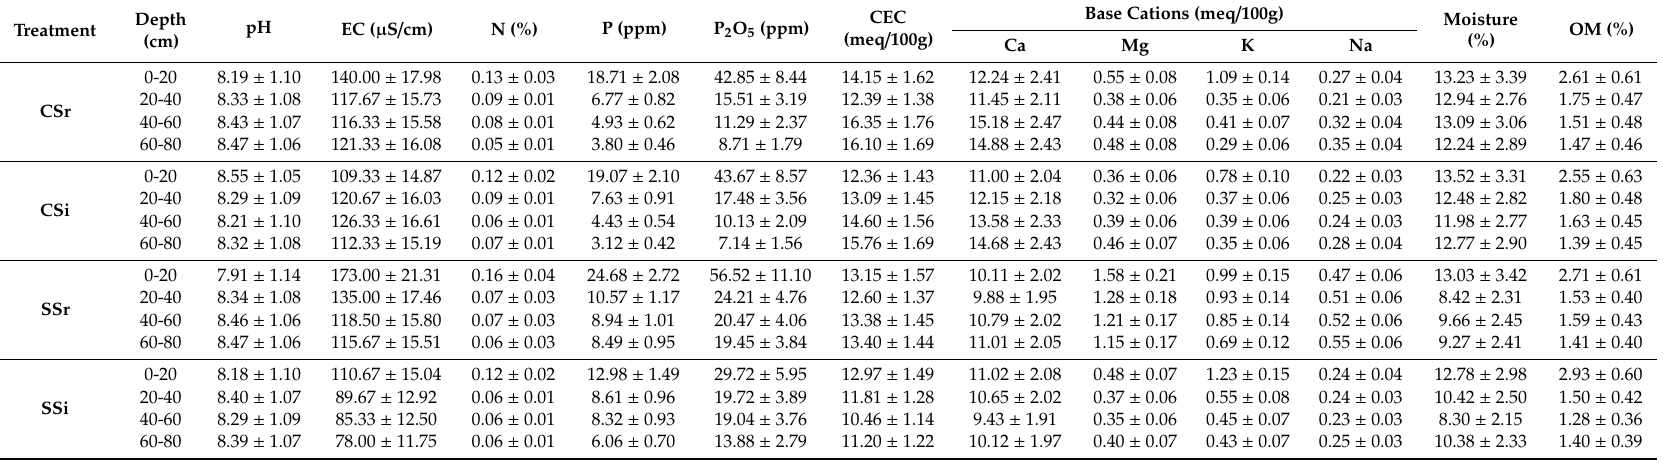
Table 2. Soil chemical and physical characteristics of the experimental olive orchards (values ± standard